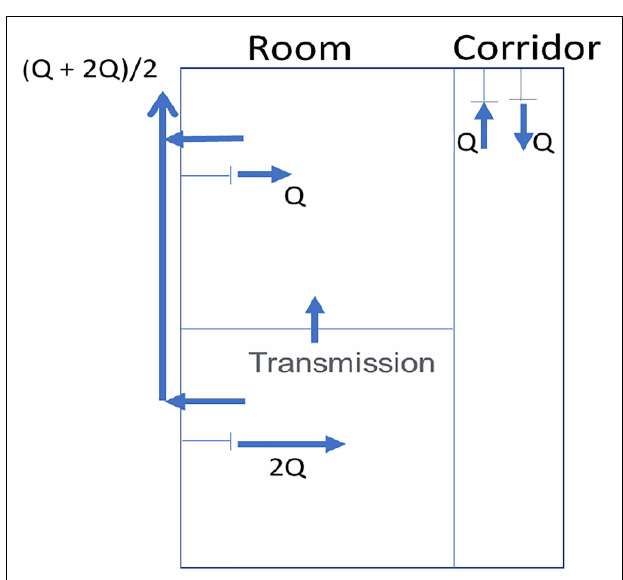
FIGURE 5 | Typical Danish design of office buildings; ( → ) and (Q) denote